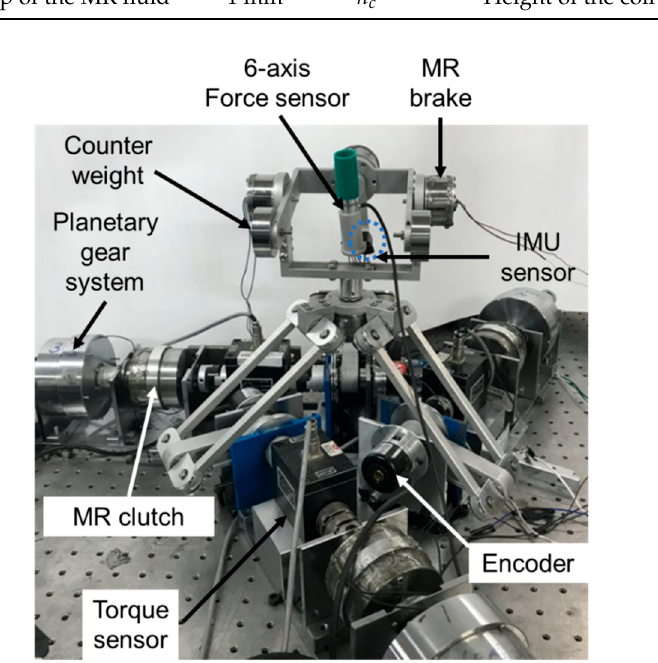
Figure 12. Photograph of the haptic master system featuring MR clutches and brakes.